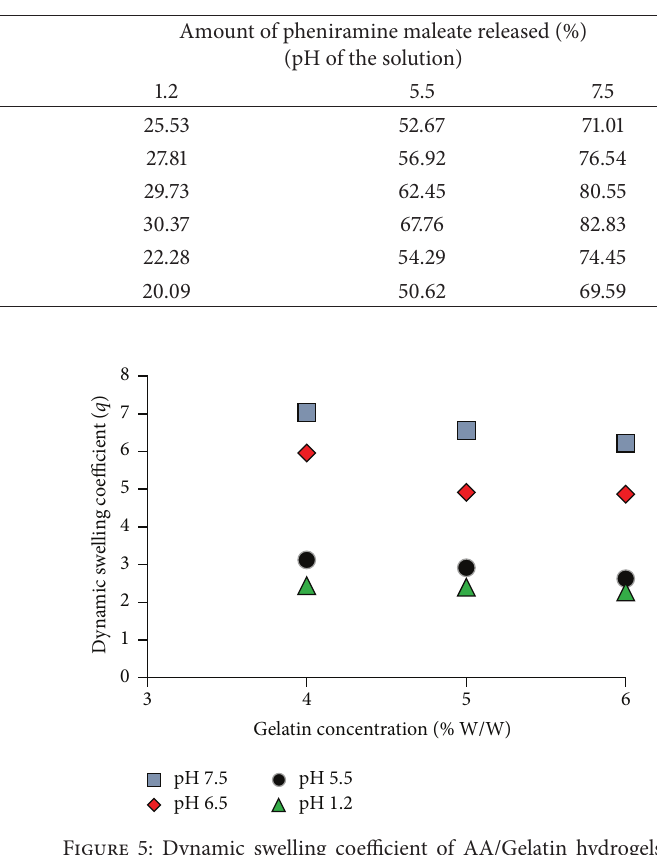
Table 3: Amount of pheniramine maleate loaded and released.